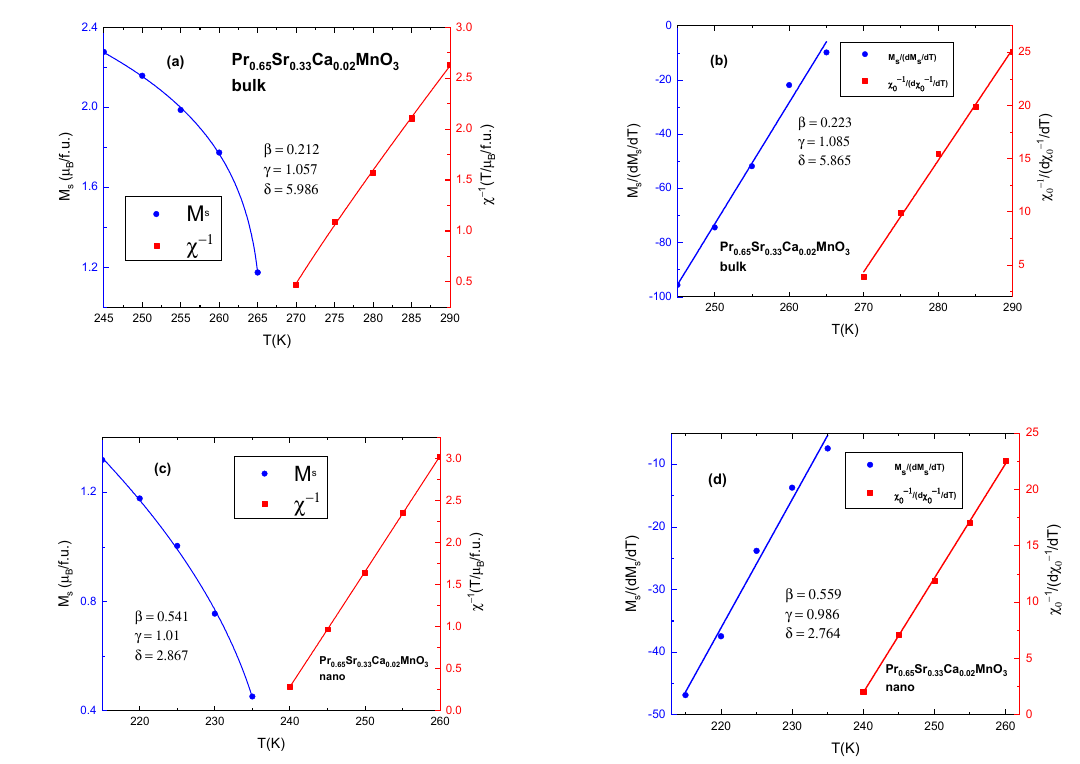
Figure 9. Calculated values for critical exponents for ( a ) MAP analysis for the bulk sample with x = 0.02 ( b ) KF analysis for the bulk sample with x = 0.02. ( c ) MAP analysis for the nanocrystalline sample x = 0.02 ( d ) KF analysis for nanocrystalline sample x = 0.02.